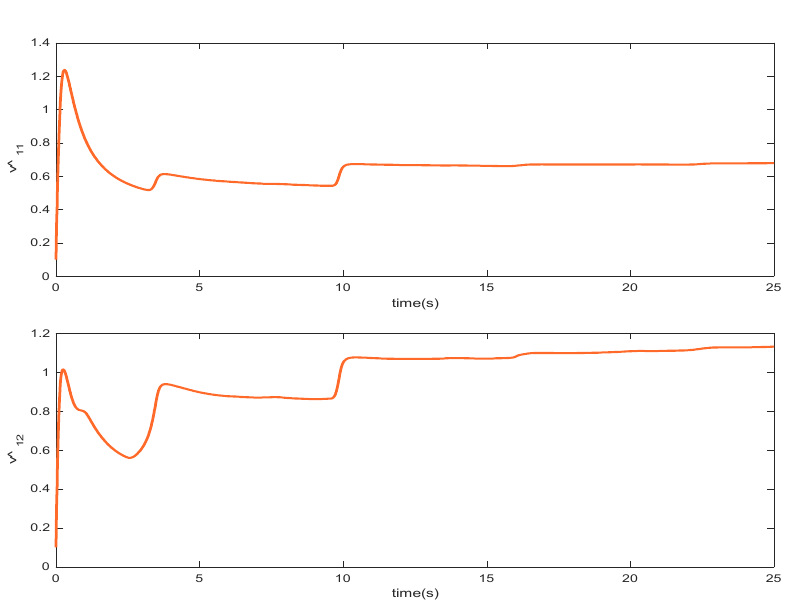
Figure 12. Adaptation laws 𝜈̂ (cid:2869)(cid:2869) , 𝜈̂ (cid:2869)(cid:2870) in Scenario 2.